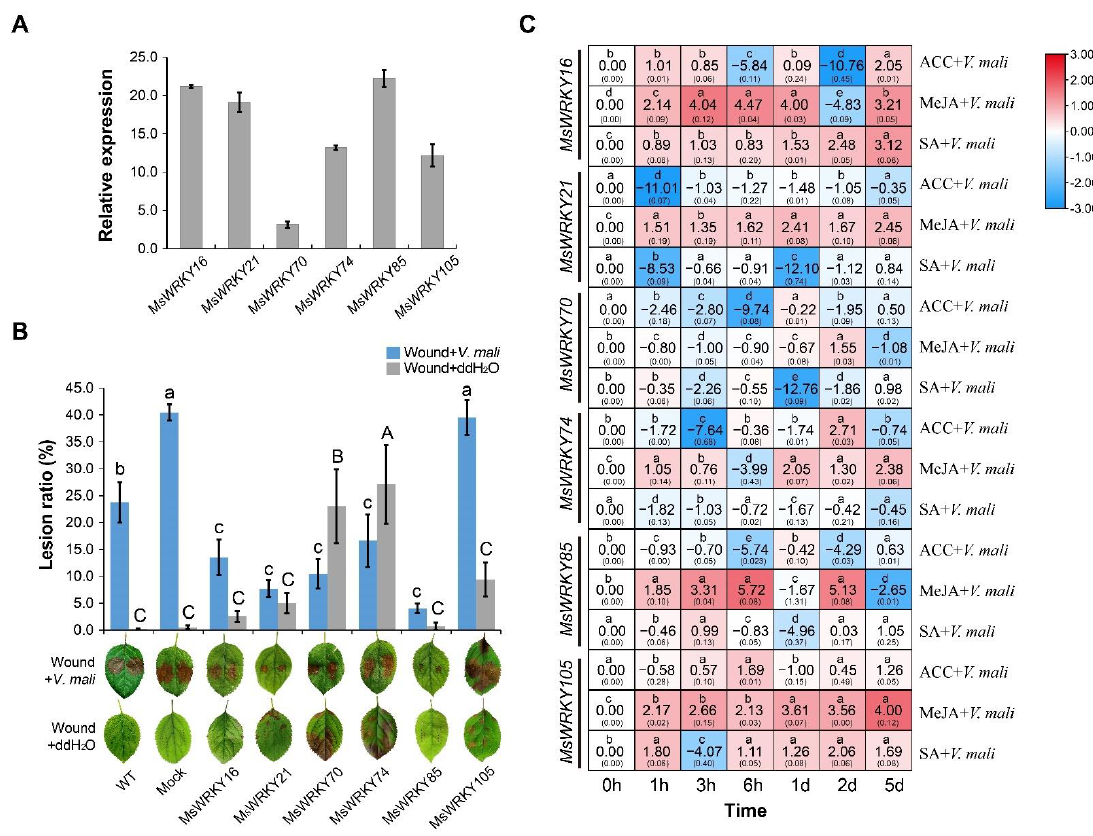
Figure 6. The functional identification of WRKY family members in M. sieversii to response to the infection of V. mali . Six MsWRKY transcripts were transiently expressed in leaves of M. domesitica . ( A ) The transfection efficiencies were determined by qRT-PCR at 4 days after transient expressions. The relative expressions were normalized with the reference gene MsEF-1 ɑ . ( B ) The Valsa canker disease resistance tests of transiently expressed MsWRKYs were presented. Mock: transiently expressed with A. tumefaciens . The lesion ratios were measured from detached leaves at 4 dpi. Each sample contained three biological replicates and each biological replicate contained three technical replicates. The means (bars: SE) were analyzed by One-way ANOVA method, Tukey’s HSD test with significances comparing with the Mock (intra-group comparison). WT: the leaves were without the transient expressions; Mock: the leaves were transiently expressed with A. tumefaciens (without vectors). Lowercase letters presented significant differences ( p < 0.05) in the Wound + V. mali group. The capital letter represented significant differences ( p < 0.05) in the Wound + ddH 2 O. ( C ) The heatmap showing the qRT-PCR validation of MsWRKY16, MsWRKY21 , MsWRKY70 , MsWRKY85 and MsWRKY105 separately in MsWRKYs transiently expressed leaves in M. domesitica under the phytohormone inductions and the V. mali infection at different time points (1 h, 3 h, 6 h, 1 d, 2 d and 5 d). The results are normalized to reference gene EF1-α and expressed as relative fold change compare to controls. The numbers in box represent the log2 of the relative expression with columns scale. The numbers in rackets represent standard errors (SEs). Phytohormones: SA (5 mM); MeJA (1 mM); ACC (1 mM). Each sample contained three biological replicates and each biological replicate contained three technical replicates. The means (bars: SE) were analyzed by ANOVA method, Tukey’s HSD test with significances comparing with the control (intra-group comparison). Lowercase letters presented significant differences ( p < 0.05). The color bar indicates expression levels from low (blue) to high (red).